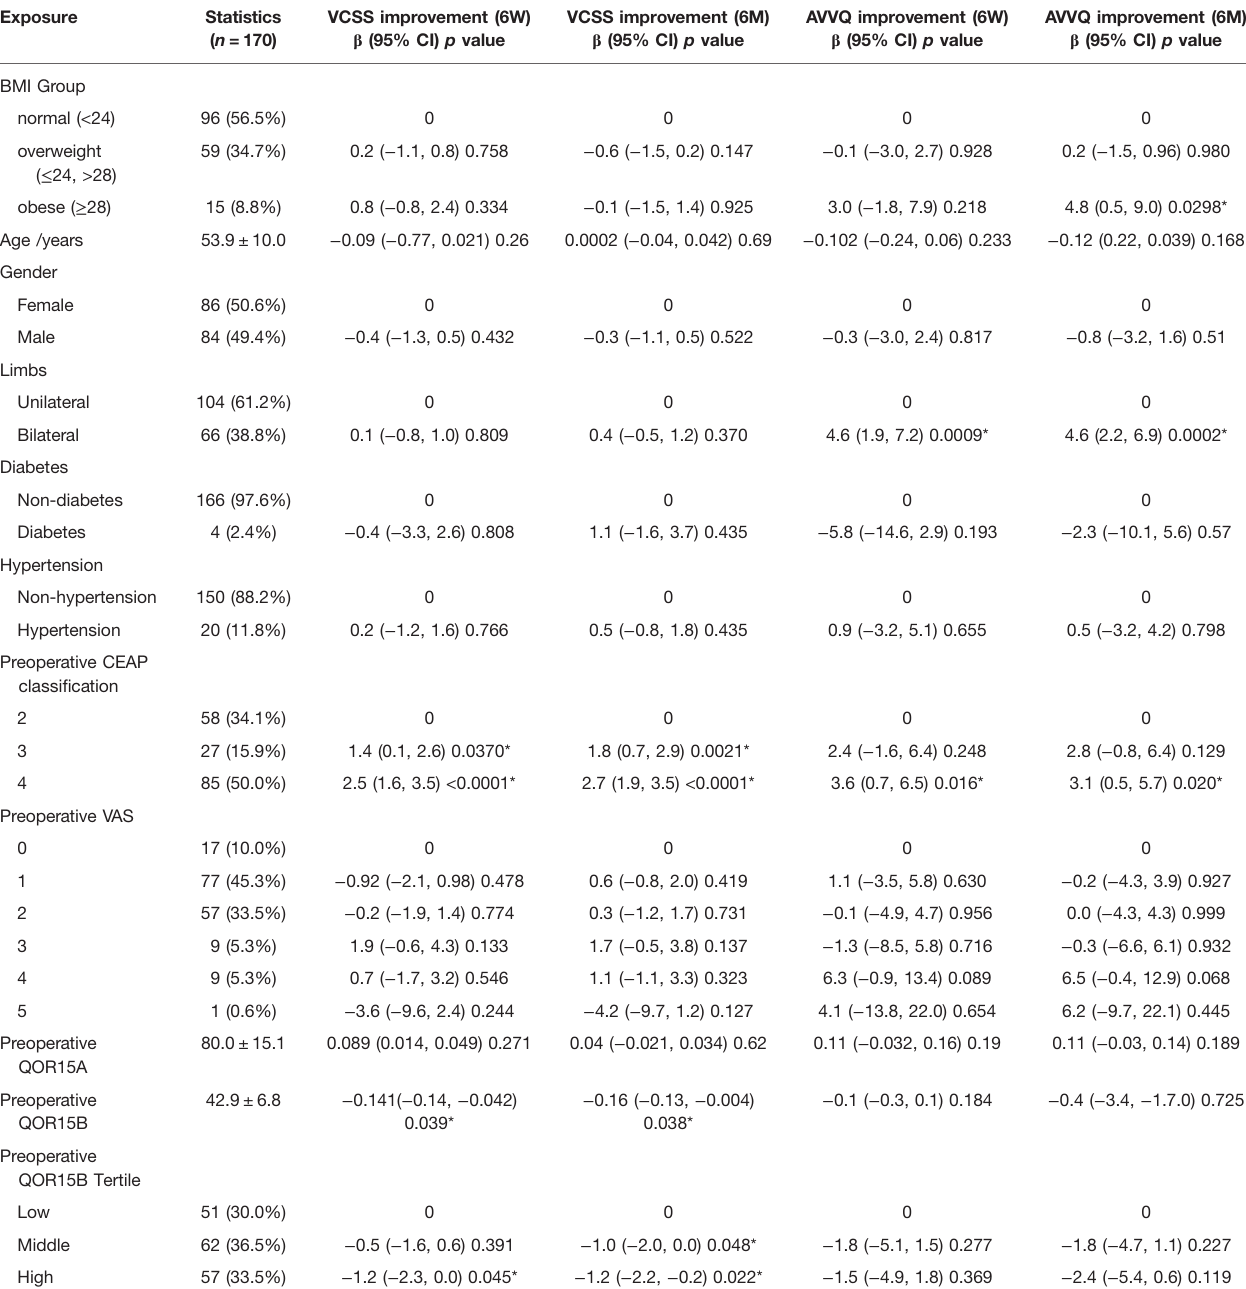
TABLE 2 | Effects of risk factors of BMI on the improvement of AVVQ and VCSS at six weeks and six months after surgery by univariate analysis.